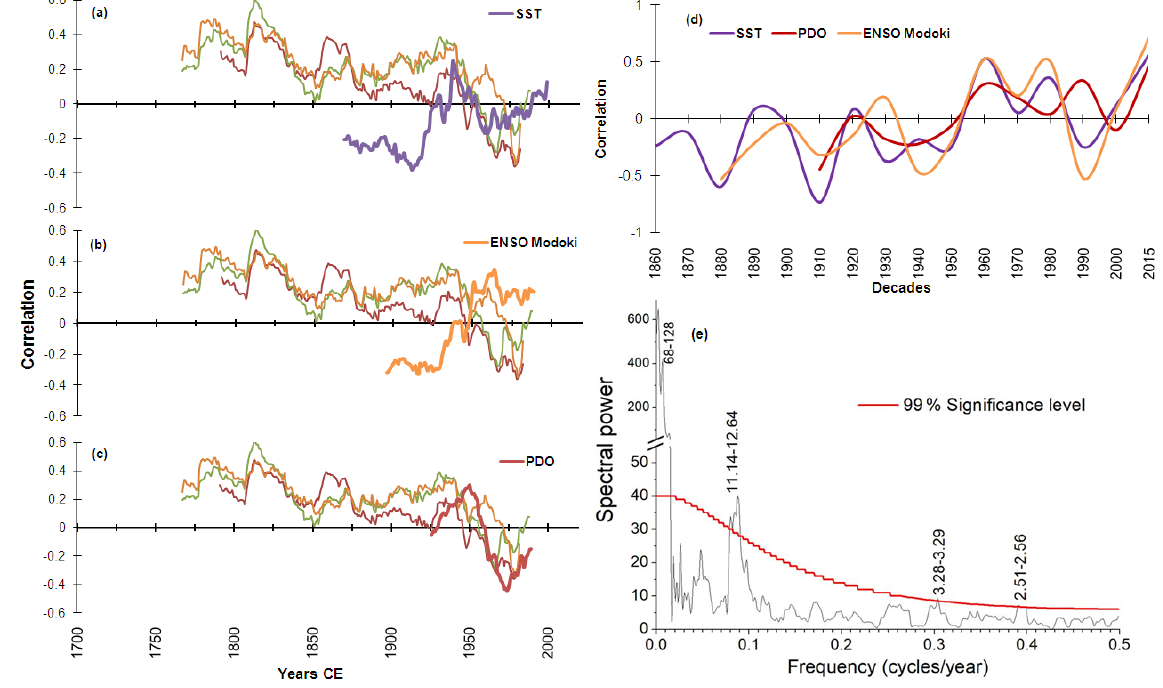
Figure 5. (a–c) Temporal correlation behaviour at a multi-decadal timescale (51 years) between tree-ring δ 18 O chronologies available from the western central Himalaya (Manali: Sano et al., 2017; Uttarakashi: Singh et al., 2019; Jageshwar: Xu et al., 2018), Niño 4 SST (violet line) (a) , ENSO Modoki (orange line) (b) , and the Pacific Decadal Oscillation (PDO; red line) (c) . (d) Strengthening decadal correlations between glacier mass balance and oceanic indices after the 1960s. (e) Spectral-analysis plot of glacier mass balance (GMB) time series reflecting low-frequency variations preserved in GMB